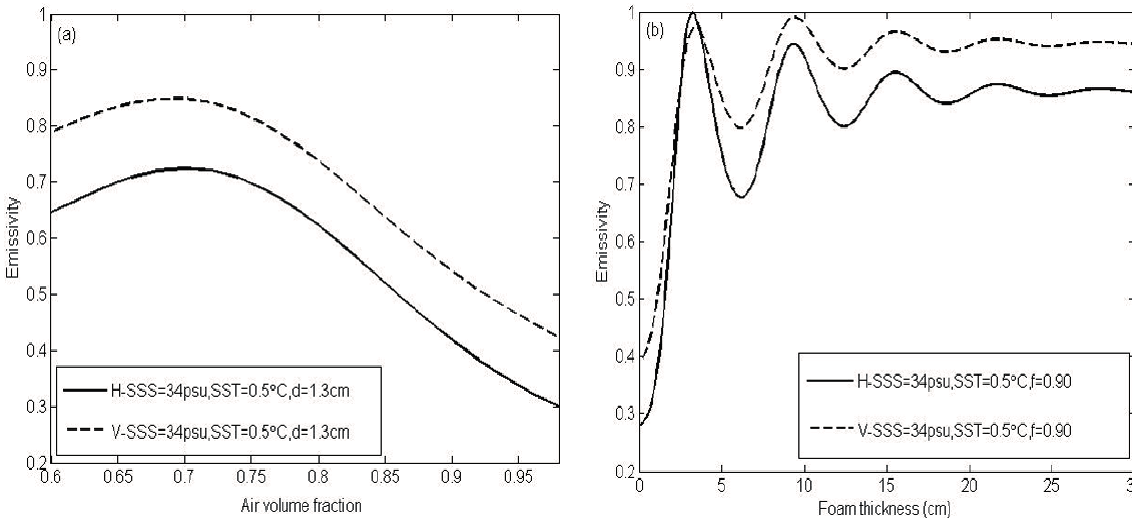
Figure 4. Foam emissivity calculated by RM emissivity model at 1.4 GHz versus AVF and foam thickness: ( a ) emissivity versus AVF for foam thickness d = 1.3 cm, SST = 0.5 °C and SSS = 34 psu; ( b ) emissivity versus foam thickness for SST = 0.5 °C, SSS = 34 psu and AVF =